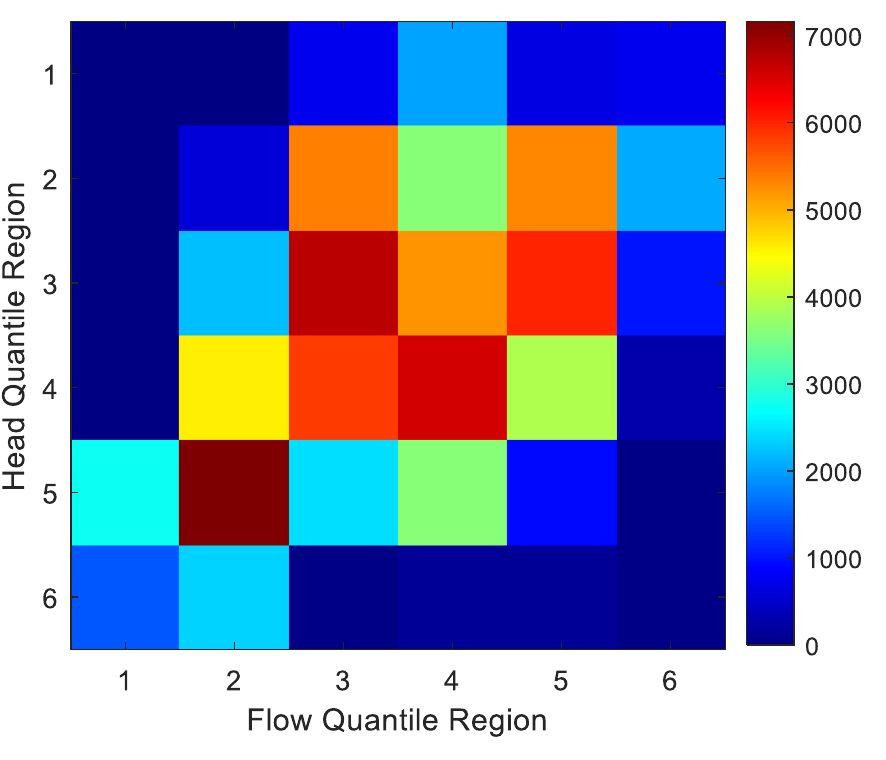
Figure 7. Thirty-six quantile regions after 1 year of operation on a single pump—as Figure 6 implied—some regions are never visited by the pump and some (non-adjacent) regions are visited frequently.